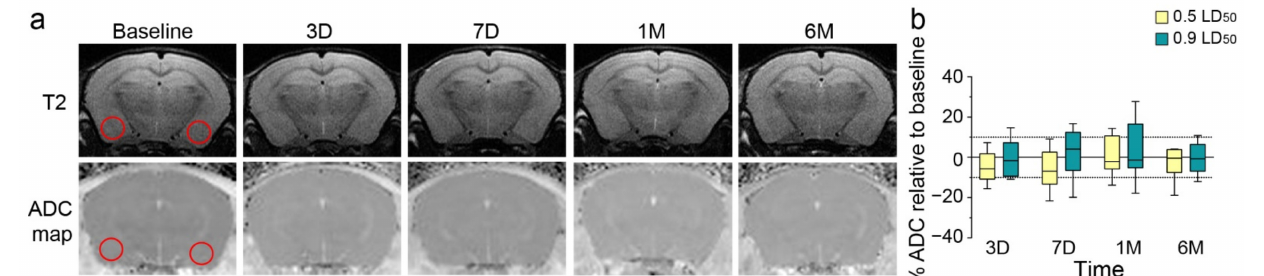
Figure 3. NIMP exposure does not induce morphological modifications or brain edema in the amygdala/piriform cortex. ( a ) T2 images with the apparent diffusion coefficient (ADC) map of one representative NIMP-exposed mouse (0.9 LD50) at different timepoints: before intoxication (baseline), and 3 days, 7 days, 1 month and 6 months after NIMP exposure. Regions of interest used for analyses are shown with red circles. ( b ) The percentage of ADC normalized to the baseline as a function of different timepoints for NIMP-exposed animal groups [(0.5 LD50: − 5.1 ± 2.7 at 3D; − 6.0 ± 3.5 at 7D; 1.7 ± 3.9 at 1M and − 2.9 ± 3.1 at 6M) and (0.9 LD50: − 0.8 ± 3.1 at 3D; 2.1 ± 4.3 at 7D; 2.9 ± 5.2 at 1M and − 0.5 ± 2.7 at 6M)]. Statistical analyses were conducted by mixed-effects model (REML) analysis (F Time = 0.89, p = 0.44; F Dose = 1.5, p = 0.24; FT imexDose = 0.36, p = 0.78) ( n = 7 to 9 per group).